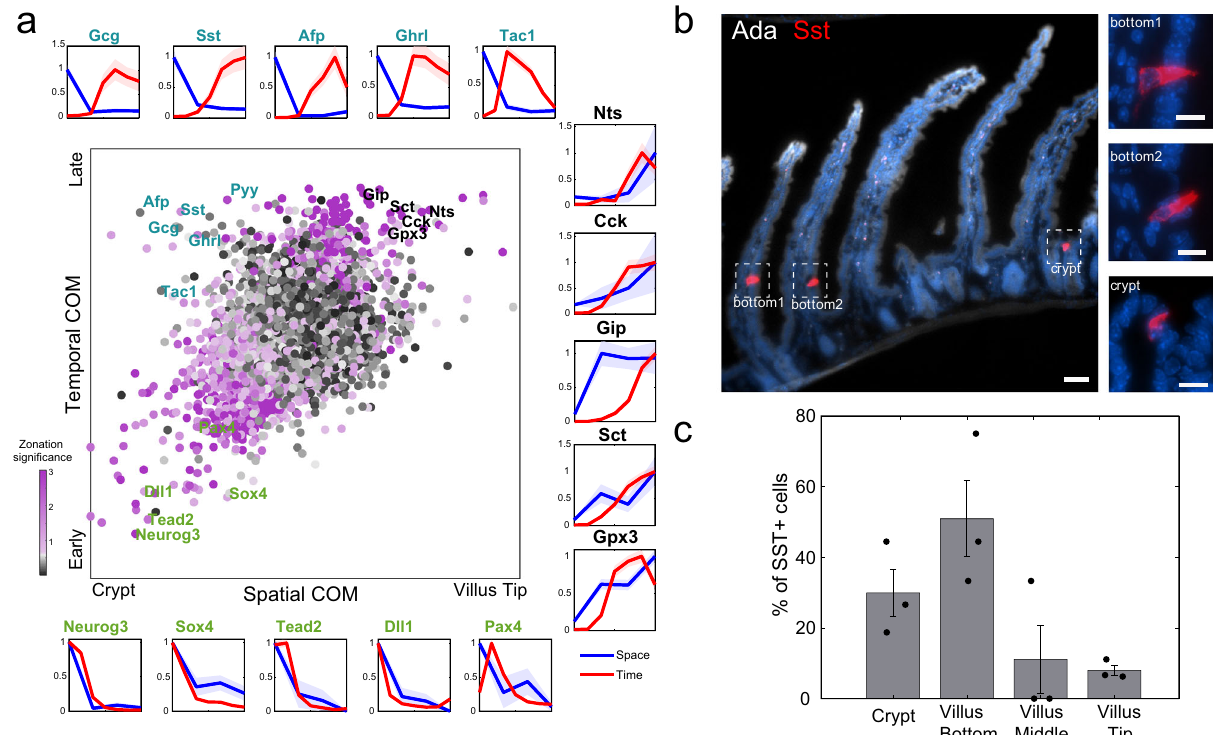
Fig. 5 Migration pattern of eneteroendocrine lineages. a Spatio-temporal analysis of enteroendocrine cells. Central plot: Scatter plot of the center of mass (COM) in our spatial zonation reconstruction vs. temporal COM based on single cell time stamps form Gehardt et al. 12 ( “ Methods ” ). Dots colored by ‒ log10(spatial zonation q -value). Peripheral plots show reconstructed temporal (red) and spatial (blue) pro fi les for early crypt-con fi ned genes (green fonts, bottom row), intermediate-late crypt/villus bottom-con fi ned genes, expressed in cells that might be migrating more slowly (cyan fonts, top row) and late villus-localized genes, expressed in cells that might be migrating more rapidly (black fonts, right column). Light areas in plots denote the SEM. b Representative smFISH images of the enteroendocrine crypt-zonated gene Sst (red). Insets are blow-ups of the Sst + cells at the crypt and bottom villus. Ada in gray marks the villi tips. Scale bars, 50 μ m in the large image and 10 μ m in the insets. c Quanti fi cation of Sst + enteroendocrine D-cells in crypt and villus bottom, middle and tip over 3 mice. Fisher exact test (two-sided) for the frequencies of D-cells between the two lower zones and two upper zones p = 3.8 × 10 − 5 . Data are presented as mean values ± SD. Source data are provided as a Source data fi